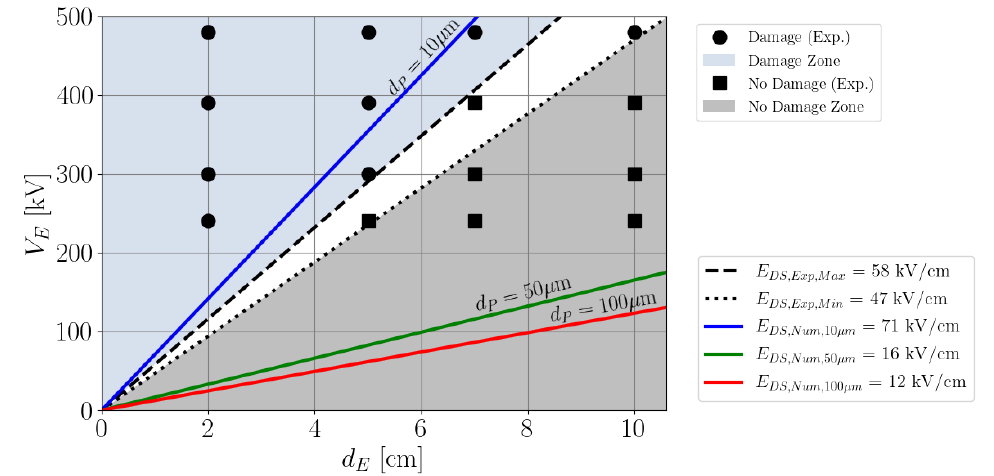
Figure 7. Comparison of the dielectric strength for granite, estimated based on the experimental data from Inoue et al. [20] ( E DS , Exp , Max , E DS , Exp , Min ) versus the predictions by our model ( E DS , Num ). Circles represent cases, where rock damage occurred in the experiments, whereas squares stand for no damage, as reported in Inoue et al.